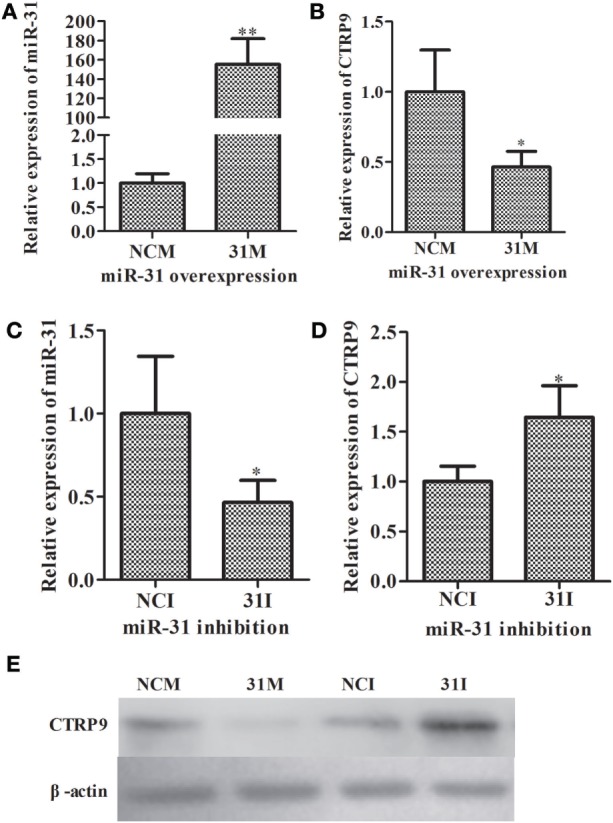
Functional analysis of miR-31 and AjCTRP9 in vivo. (A) Relative miR-31 expression level after transfection with modified microRNA (miRNA) mimics. (B) Relative expression level of AjCTRP9 after transfection with modified miRNA mimics. (C) Relative miR-31 expression level after transfection with modified miRNA inhibitor. (D) Relative expression level of AjCTRP9 after transfection with modified miRNA mimics. (E) Western blot analysis of AjCTRPP protein after transfection with modified miRNA mimics or inhibitor. Values are given as the mean ± SD, n = 5. Asterisks indicate significant differences: *p < 0.05, **p < 0.01.